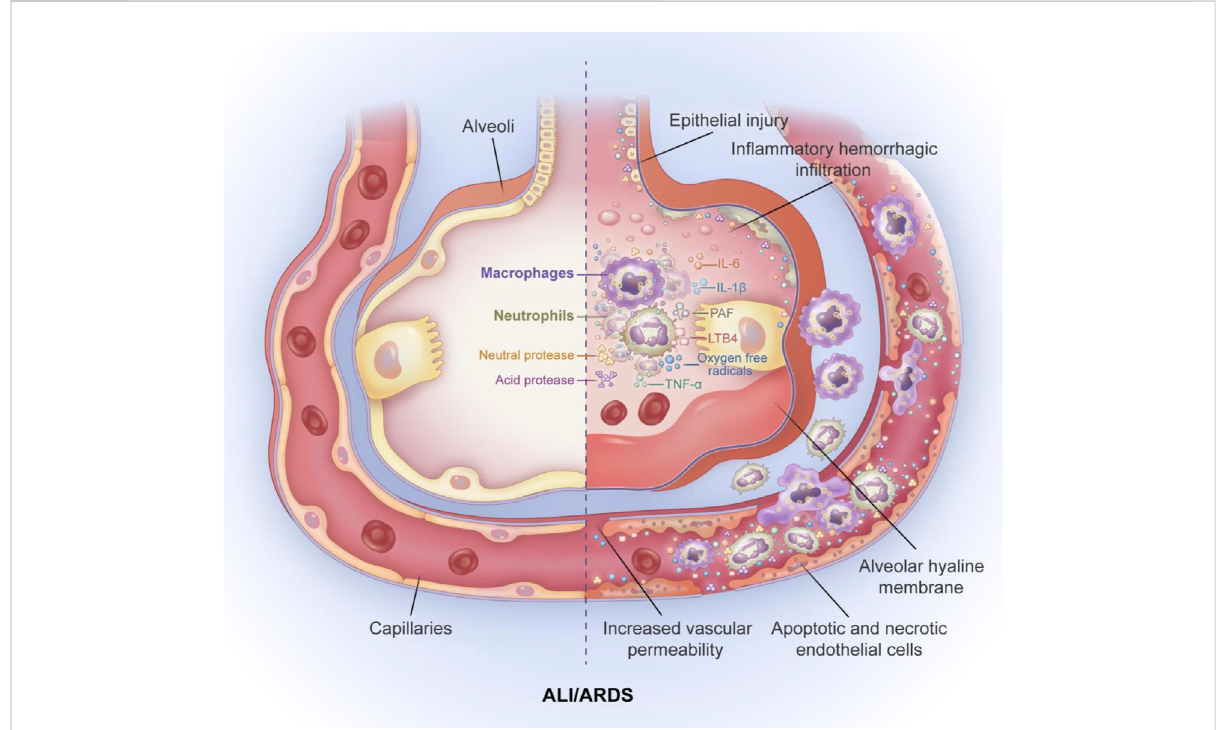
FIGURE 1 The pathological features of ALI/ARDS. The main pathological feature of ALI/ARDS is diffues injury of pulmonary capillary endothelial cells and pulmoary epithelial cells accompanied by alveolar hyaline membrane formation, increased pulmonary vascular permeability and in fl amatory hemorrhagicin fi ltrateofalveolarspace.Themechanismofincreasedalveolarcapillarypermeabilityismainlythereleaseofin fl ammatoryfactorsand the aggregation of in fl ammatory cells. neutrophils and macrophages accumulate in the alveolar space and release large amounts of in fl ammatory cytokines TNF- α , IL-6, IL-1 β . In addition, neutrophils can also release large amounts of oxygen free radicals, leukotriene B4 (LTB4), platelet activating factor (PAF), and various neutral and acidic proteases, leading to apoptosis and necrosis of alveolar epithelial cells and alveolar capillary endothelial cells, and ultimately to increased permeability of alveolar capillary endothelial